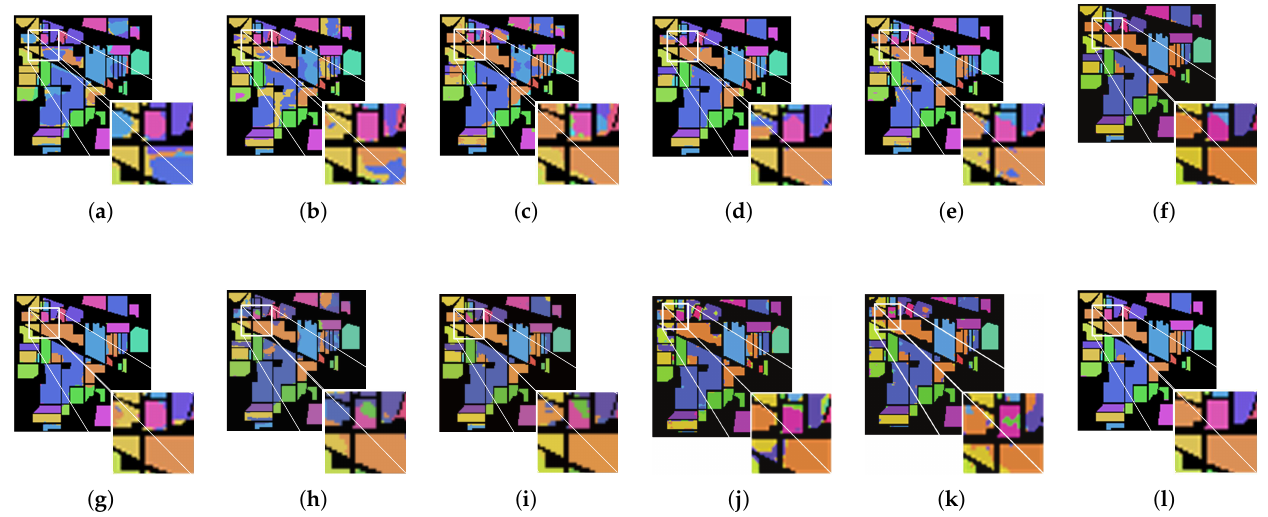
Figure 10. Classification maps for IP data set. ( a ) SVM. ( b ) RF. ( c ) MLR. ( d ) ResNet. ( e ) PyResNet. ( f ) ContextualNet. ( g ) SSRN. ( h ) ViT. ( i ) SSFTT. ( j ) LeViT. ( k ) HiT. ( l ) NEHTNet.